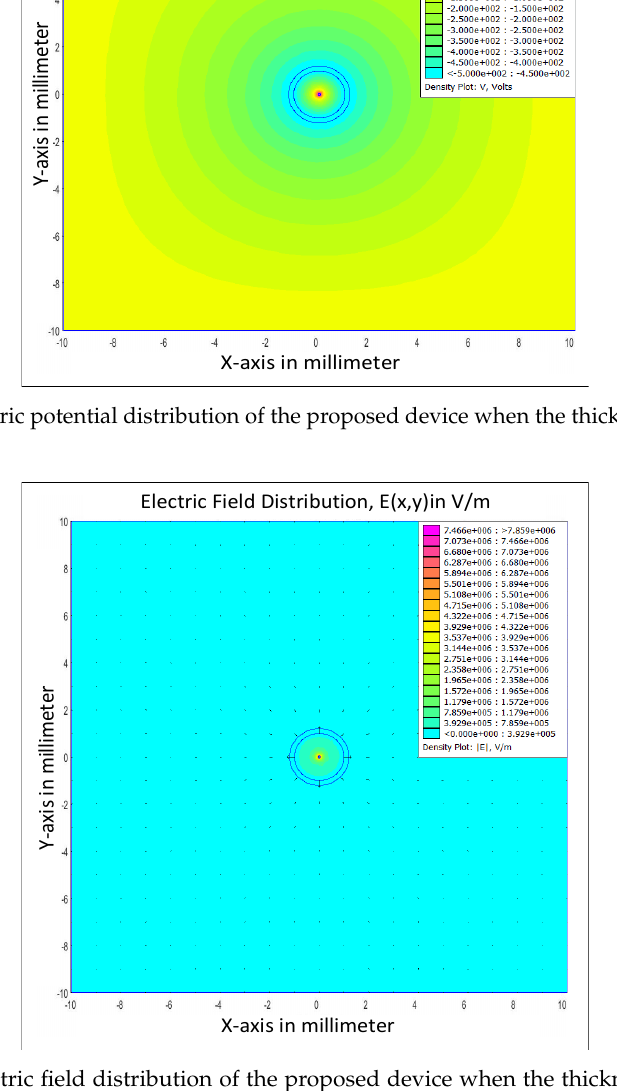
Figure 17. The electric field distribution of the proposed device when the thickness of metal sheet is